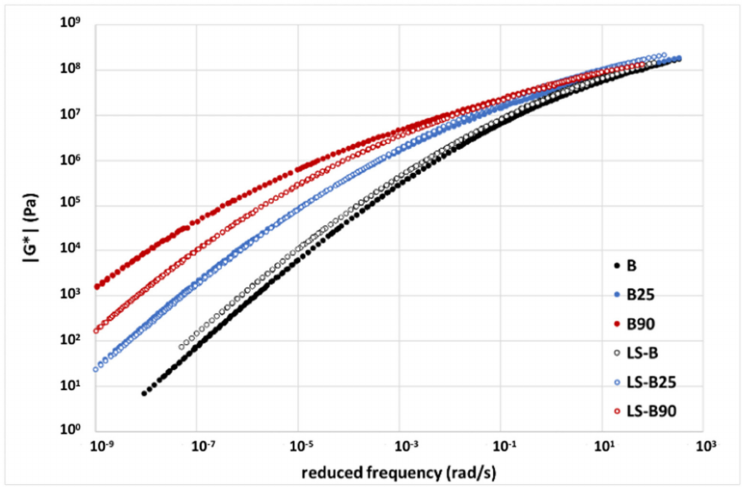
Figure 4. Magnitude of complex modulus for the same samples reported in Figure 3. Reference temperature 0 ◦